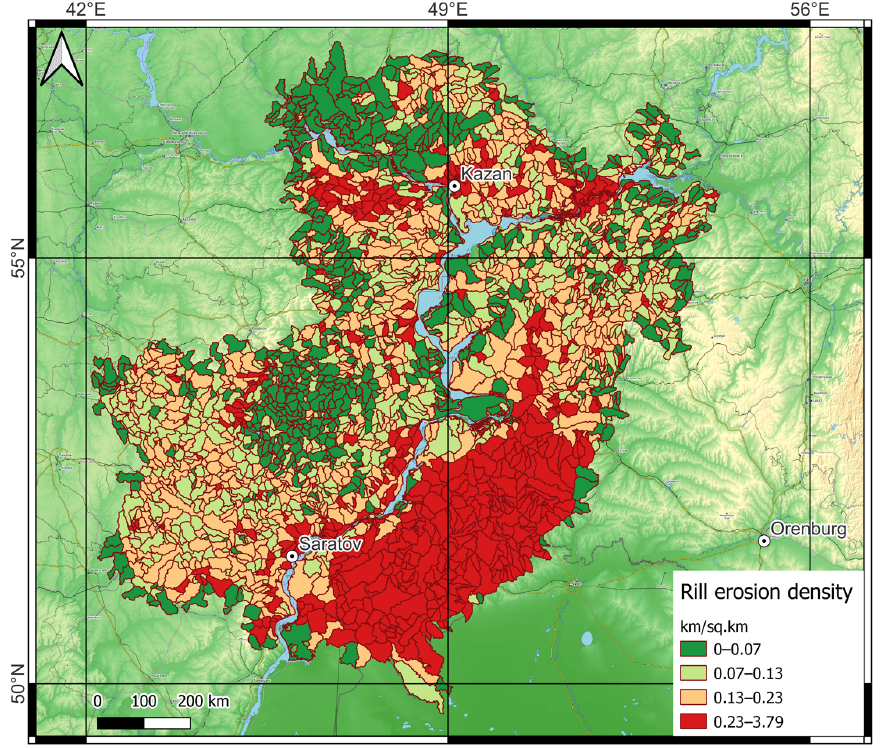
Figure 7. Map of rill erosion density. Quartiles calculate intervals.